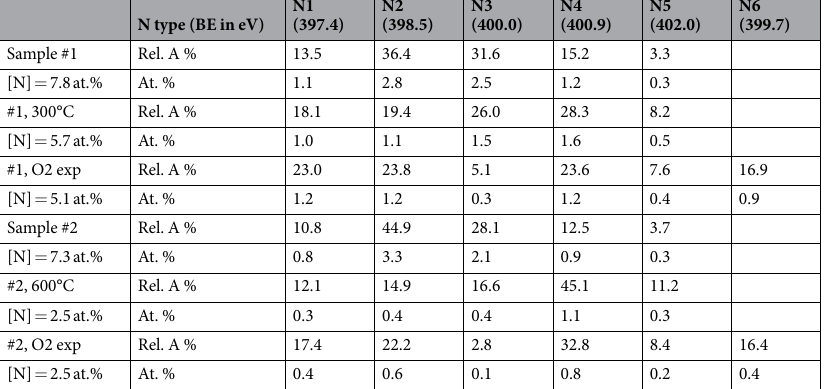
Table 1. Summary of the peak fitting analysis of the N 1 s core level spectra of the two samples annealed at 300 and 600 °C and after O 2